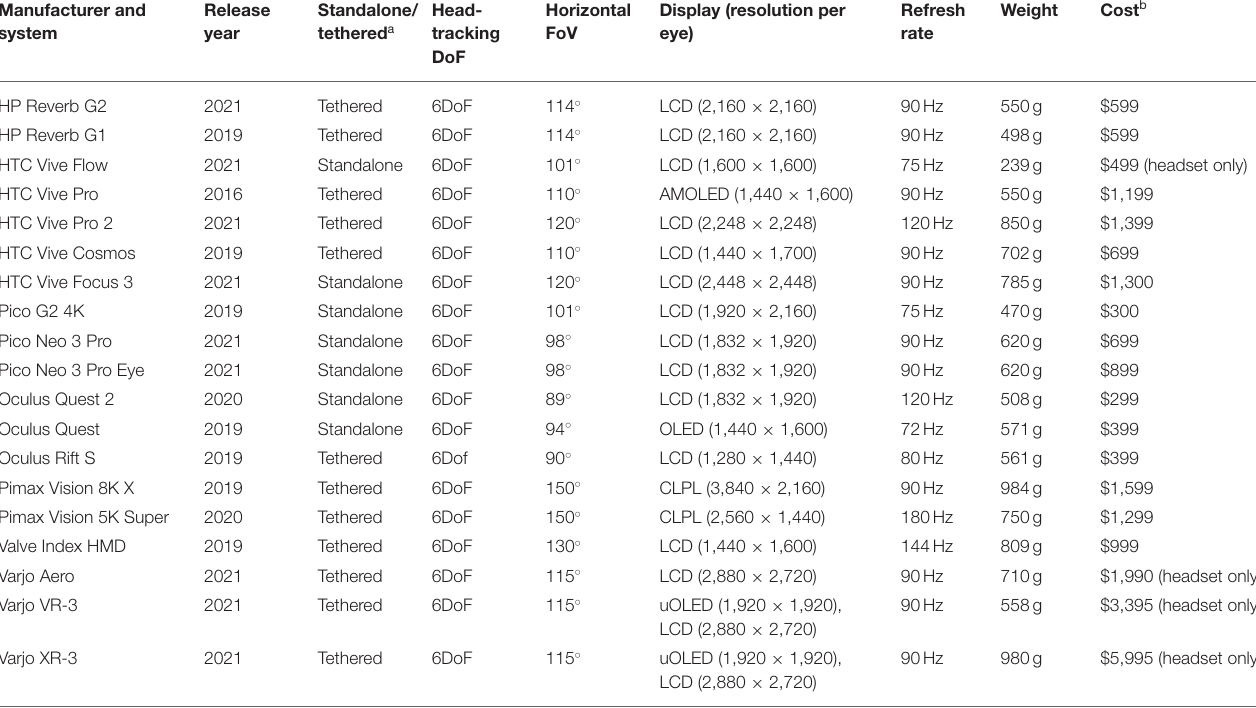
TABLE 1 | Integrated immersive VR systems commercially available. Manufacturer and